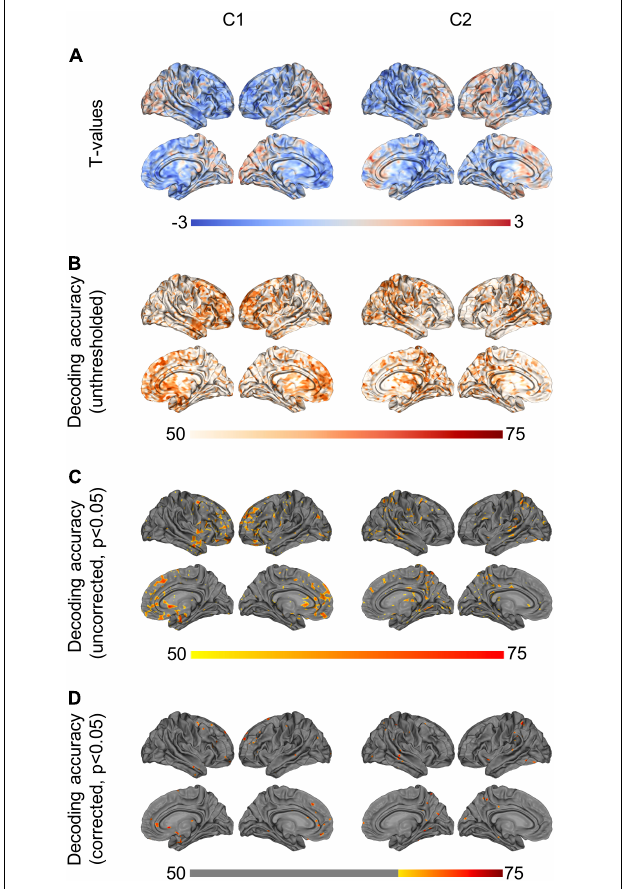
FIGURE 3 | Group differences and machine-learning results. (A) Shows t -values from the unpaired t -tests (non-significant), showing (controls—patients). Positive (red) t -values illustrate brain regions where patients show smaller C1/C2 values than controls, while negative (blue) t -values illustrate regions where patients have larger C1/C2 values than controls. (B) Shows unthresholded DA values based on logistic regression, using C1/C2 as a single feature. (C) Shows the same DA values, thresholded at p < 0.05. (D) Shows the DA values corrected for multiple comparisons using maximum statistics ( p < 0.05), thresholded at the chance level of 70%. P-leader p = 2 was used. DA, decoding accuracy.